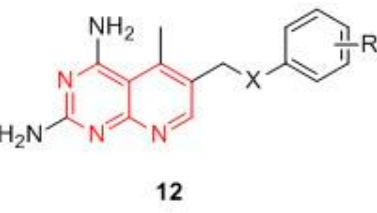
Figure 7. General structure of pyridopyrimidine derivatives.